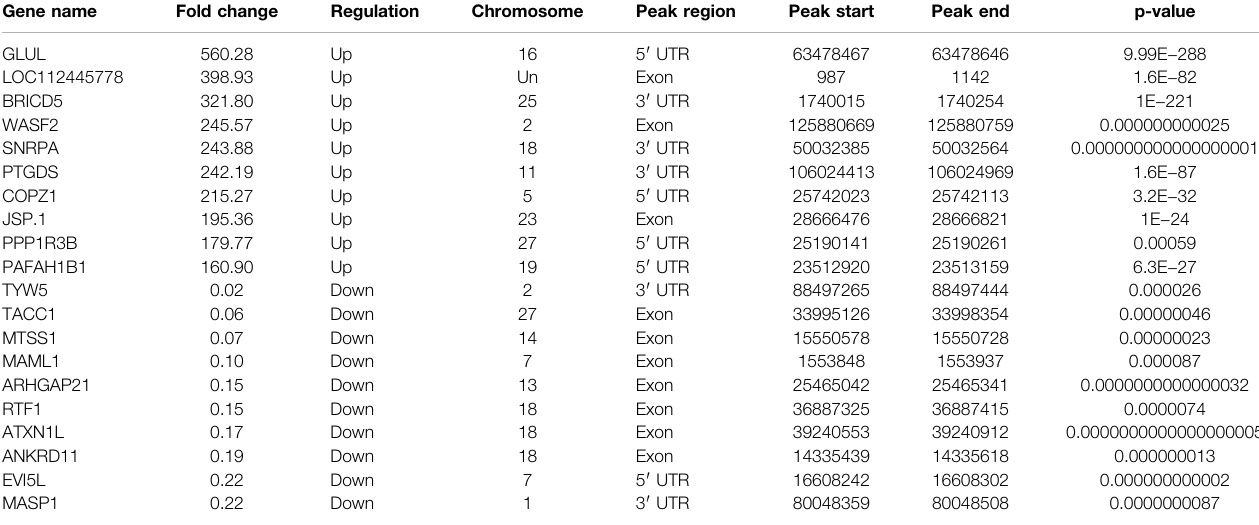
TABLE 4 | The top 20 differentially expressed m6A